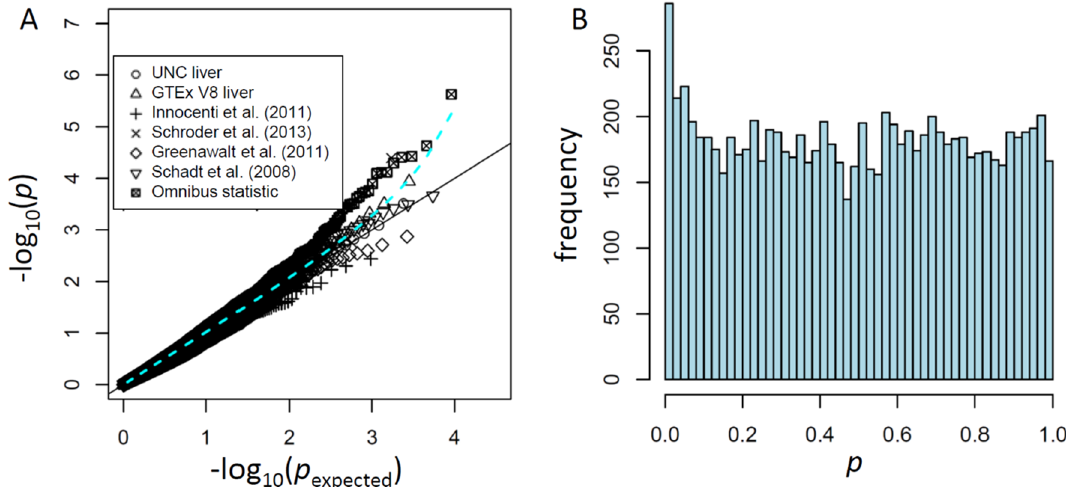
Figure 5. A small neutropenia GWAS study ( n = 294) illustrates the power of TWAS analysis from combined liver eQTL sources. ( A ) Quantile–quantile plot of − log10( p values) for TWAS analyses using four earlier liver eQTL studies and two RNA-Seq liver eQTL studies. ( B ) Histogram of p values for the omnibus